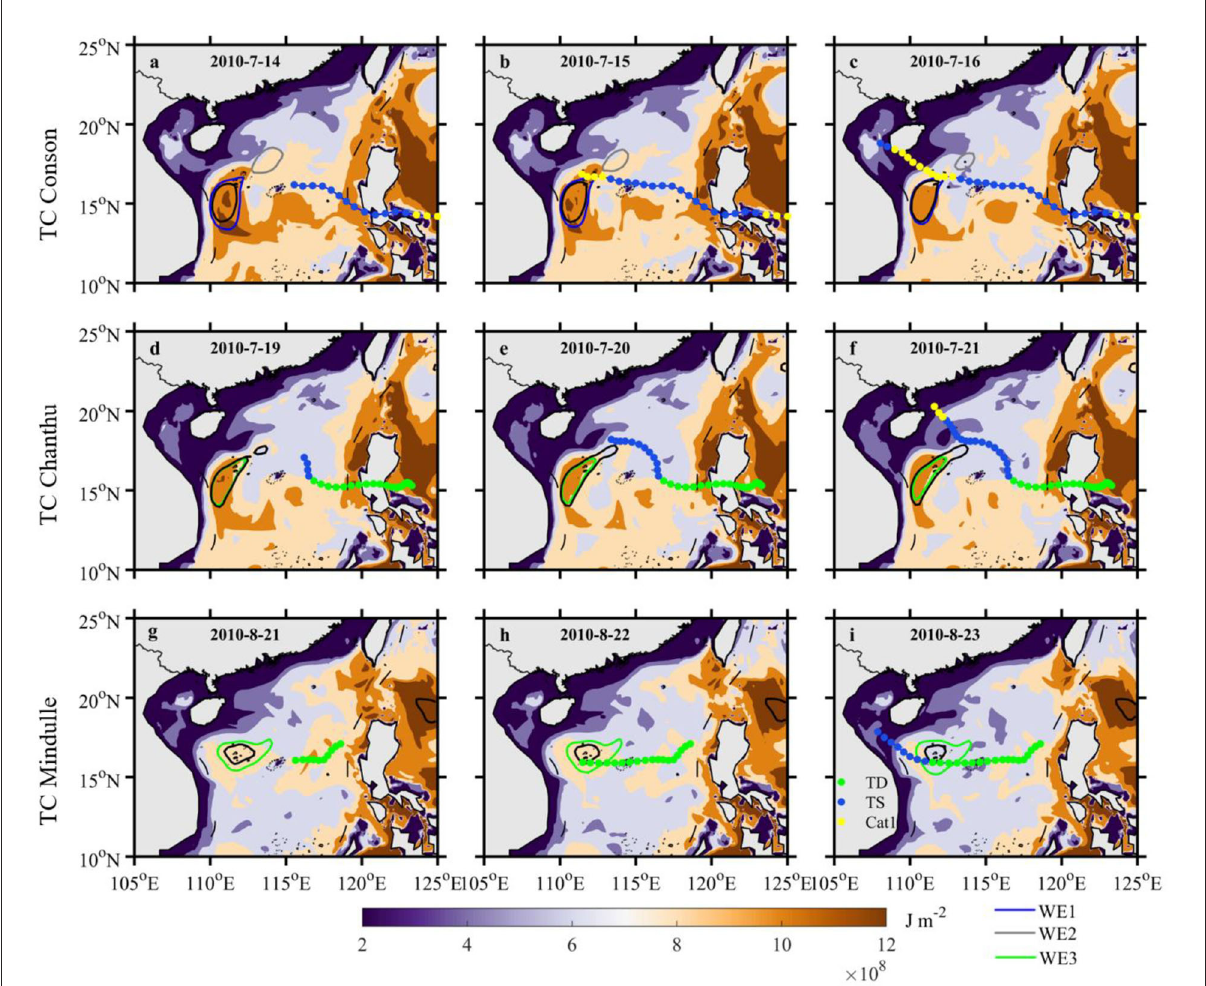
FIGURE3 The TCHP (shading; unit: J m − 2 ) in the SCS 1 day before TCs pass over the warm eddy (a,d,g) , the day TCs pass over the warm eddy (b,e,h) , and 1 day after TCs passed over the warm eddy (c,f,i) . The dots represent the location and trajectory of TCs. Green, blue, and yellow dots indicate the tropical depression, tropical storm, and Category 1 typhoon (based on the Saffir-Simpson scale), respectively. Black contours represent the 0.4m SLA. Blue, gray, and green contour represents the boundary of WE1, WE2, and WE3,